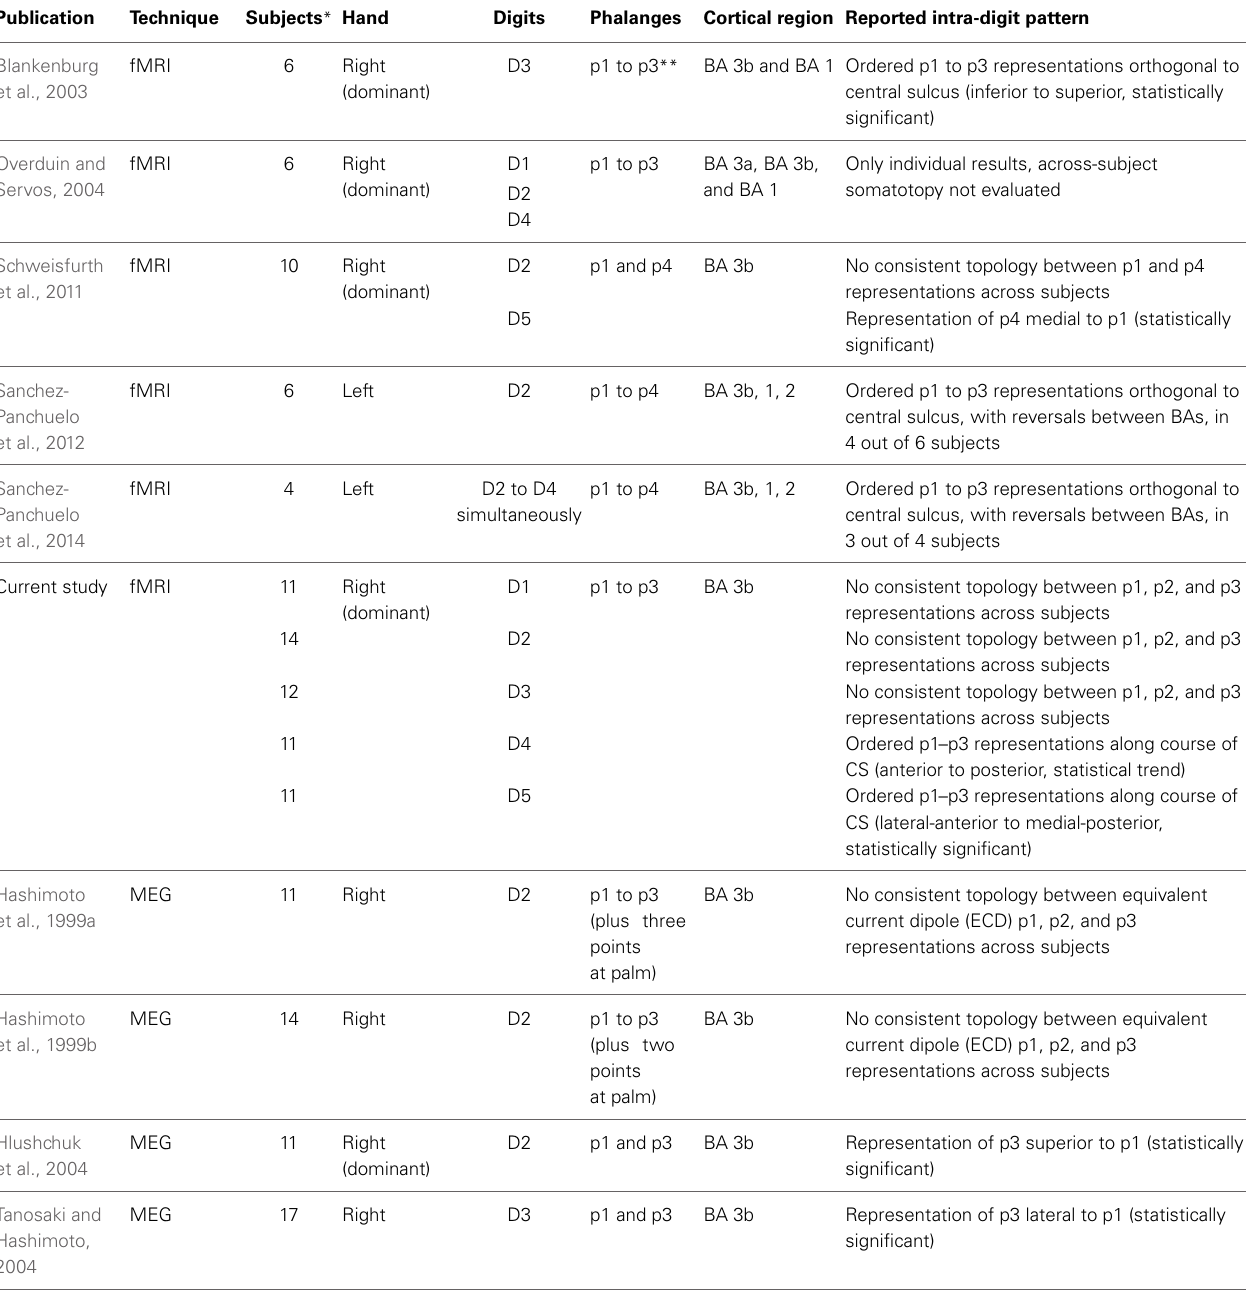
Table 1 | Overview of fMRI and MEG studies of intra-digit topology on individual human